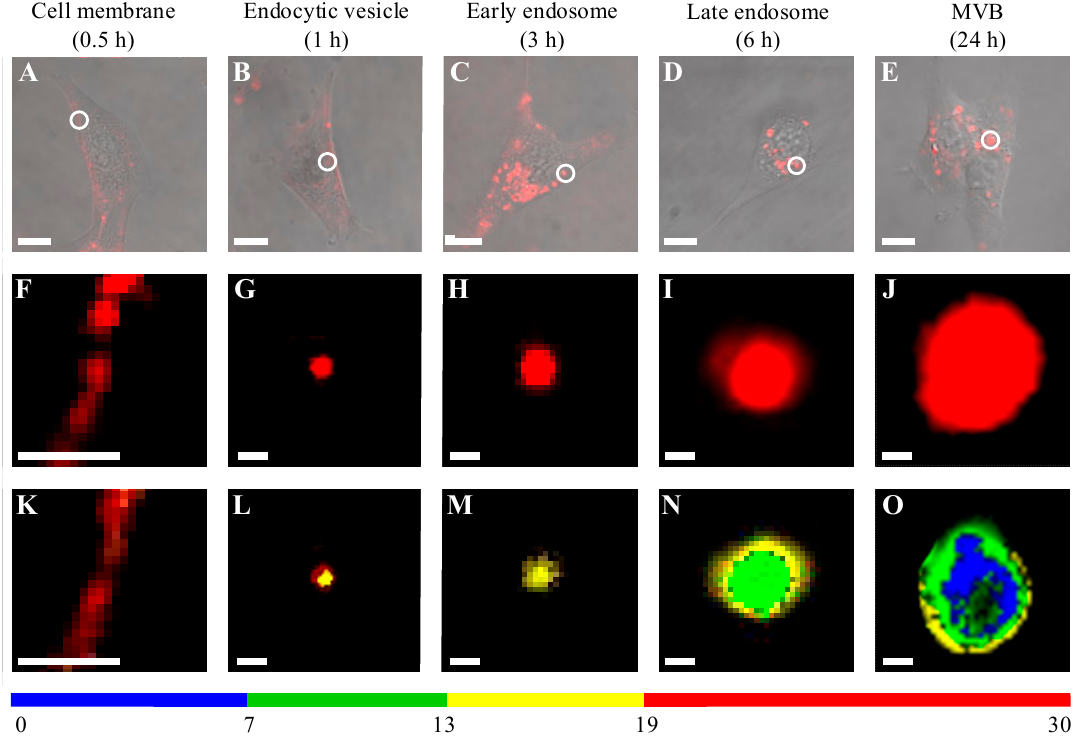
Figure 3. Overlaid phase contrast and confocal photoliuminescence images of NIH3T3 cells at different times of incubation with QDs revealing their intracellular distribution: ( A ) QDs adherent to the membrane; ( B , C ) endocytotic vesicles and early endosomes distributed in the cytoplasm; ( D ) late endosomes are concentrated in a perinuclear region; ( E ) multi-vesicular body-like structures distributed in the cytoplasm; scale bar: 10 μ m. Confocal fluorescence images and fluorescence-lifetime images of areas and vesicles marked with white circles in ( A – E ): membrane ( F , K ); endocytotic vesicle ( G , L ); early endosome ( H , M ); late endosome ( I , N ); and multi-vesicular body (MVB) ( J , O ); scale bar: 1 μ m.